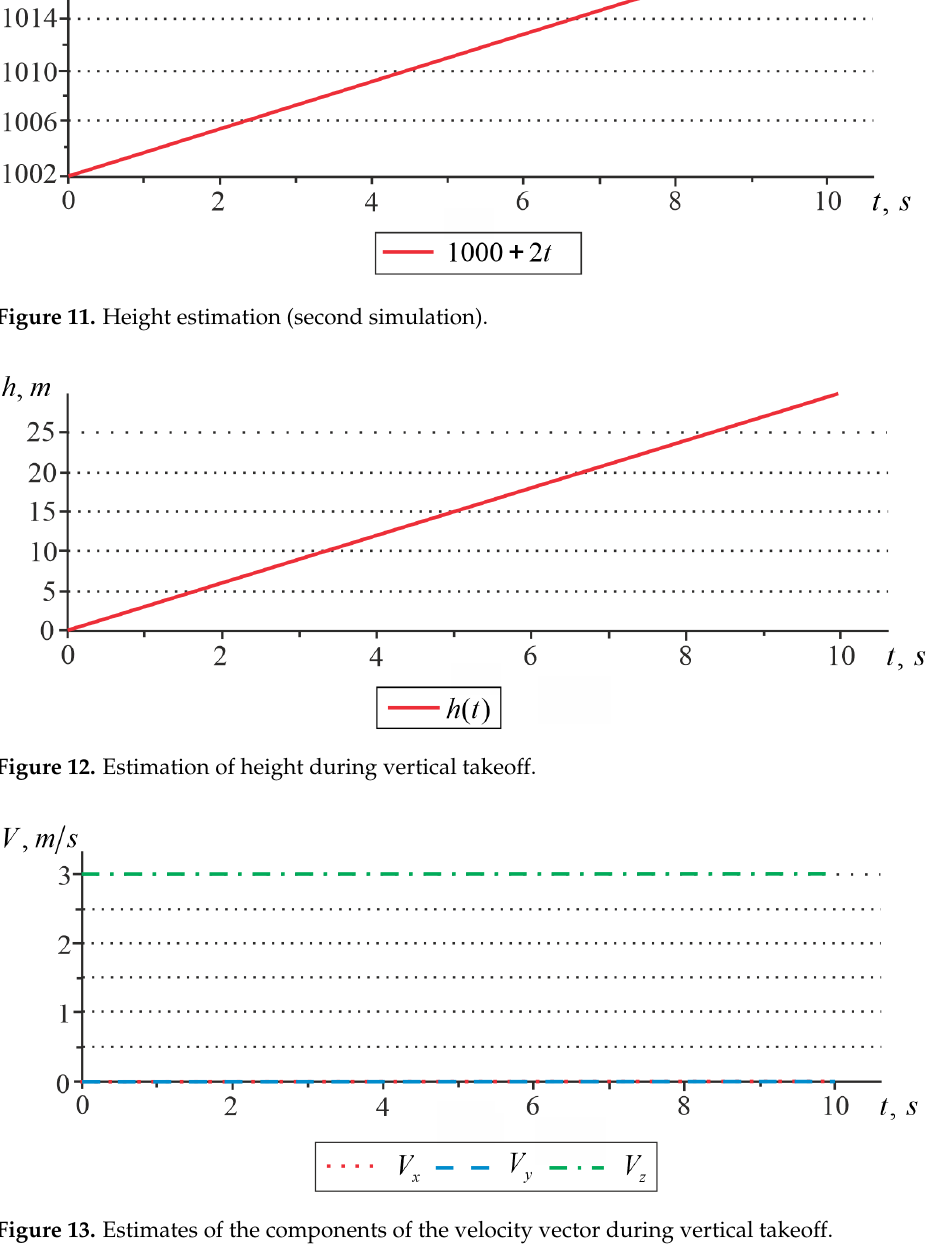
Figure 11. Height estimation (second simulation).